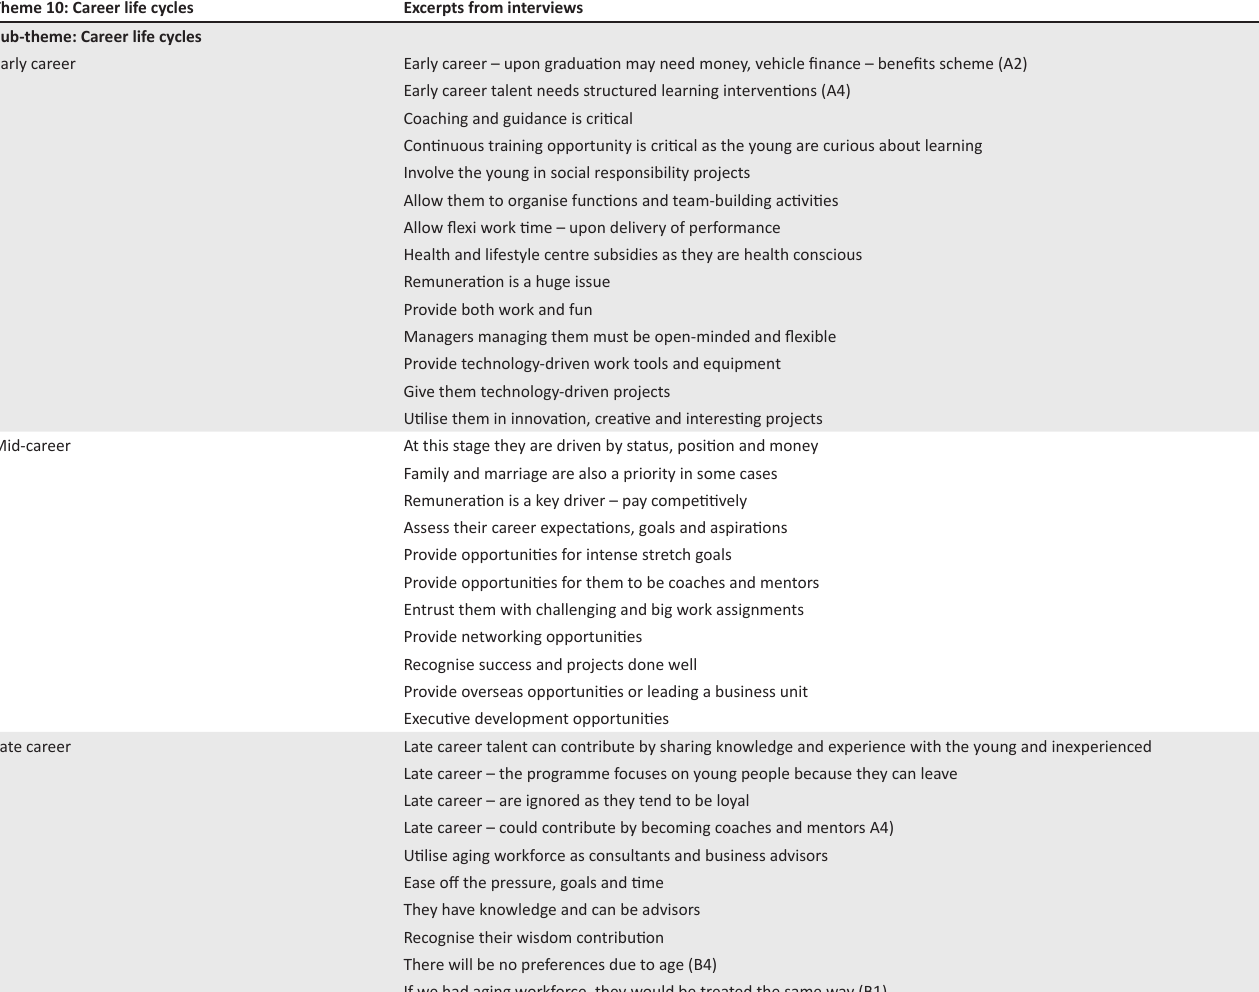
TABLE 10: Career life stages. Theme 10: Career life cycles Excerpts from interviews Sub-theme: Career life